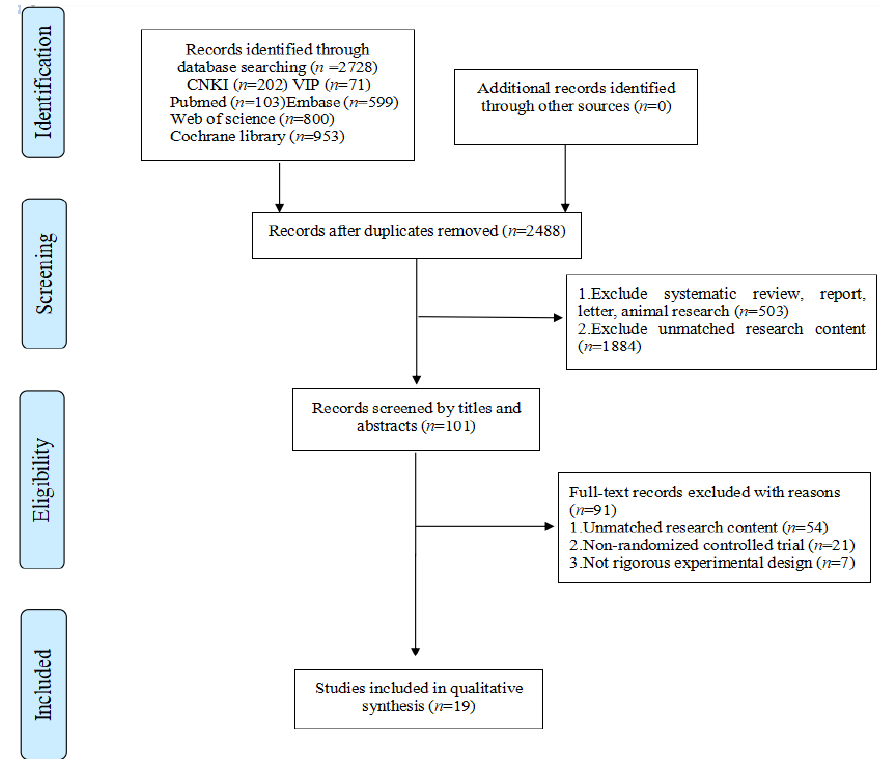
Figure 1. Flow Diagram of Study Selection.